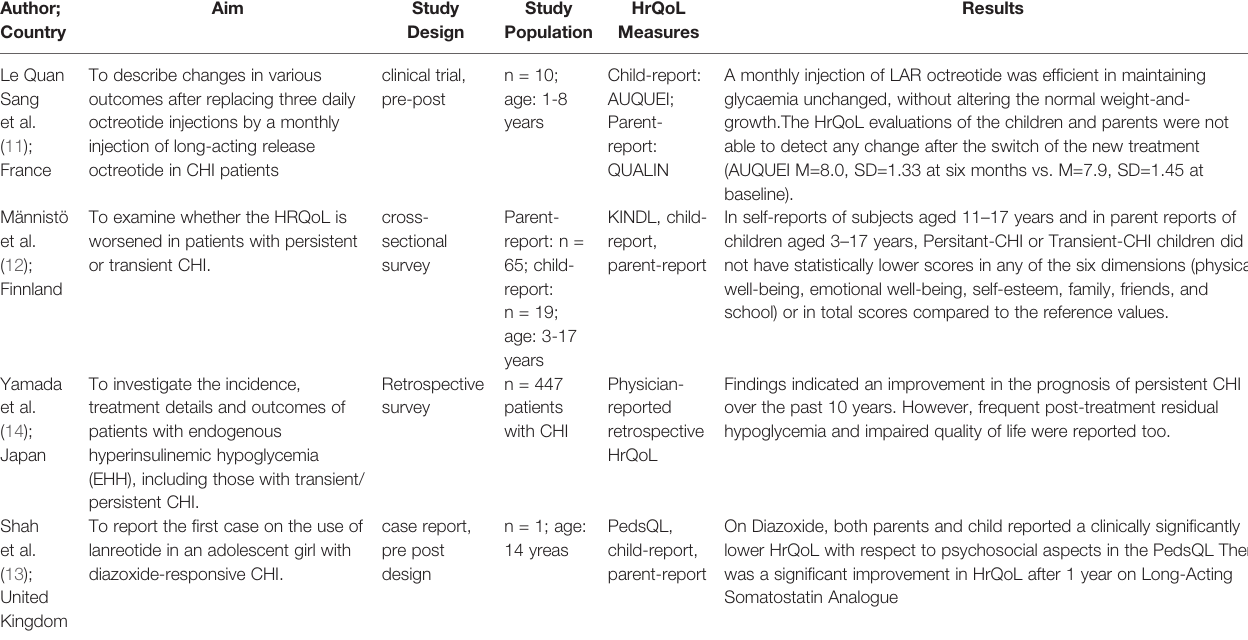
TABLE 1 | Summary of included